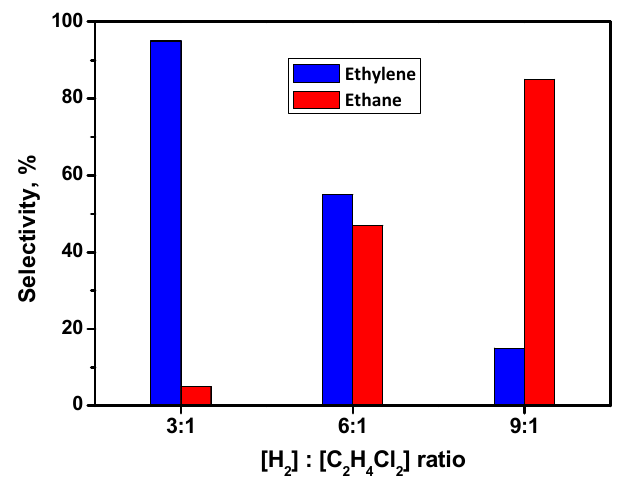
Figure 4. E ff ect of the hydrogen excess on the selectivity of Ni / Al 2 O 3 catalyst towards ethylene and Figure 4. Effect of the hydrogen excess on the selectivity of Ni/Al 2 O 3 catalyst towards ethylene and ethane. The hydrodechlorination of 1,2-DCE was performed at 350 ◦ C and τ = 0.4 s. ethane. The hydrodechlorination of 1,2-DCE was performed at 350 °C and τ = 0.4 s.